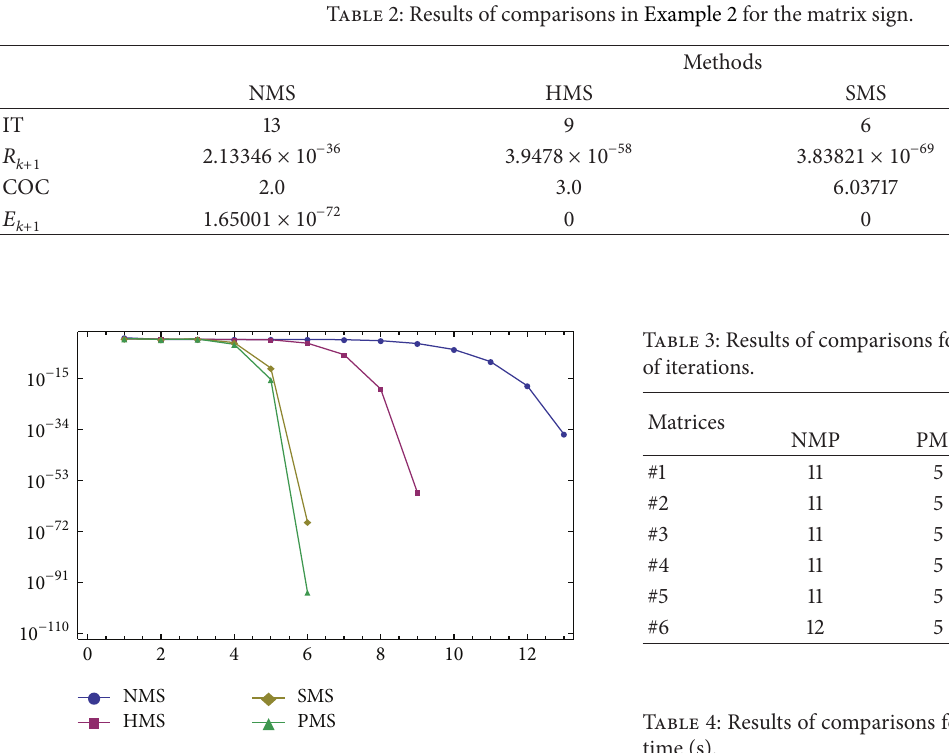
Figure 6: Convergence history of different methods using logplot in Example 2 with high precision computing.